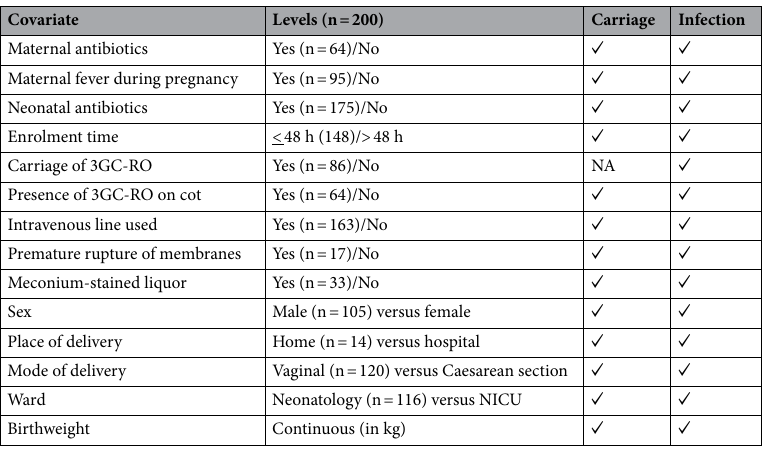
Table 2. Covariates used in the two sets of logistic regression models. 3GC-RO third-generation cephalosporin-resistant organism, NA not applicable.